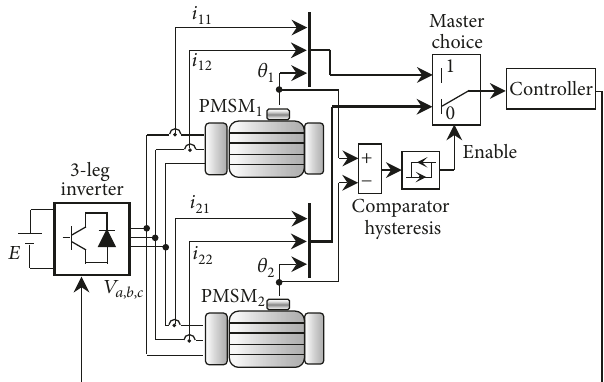
Figure 2: Parallel structure studied, bimachine monoinverter sys- tem.